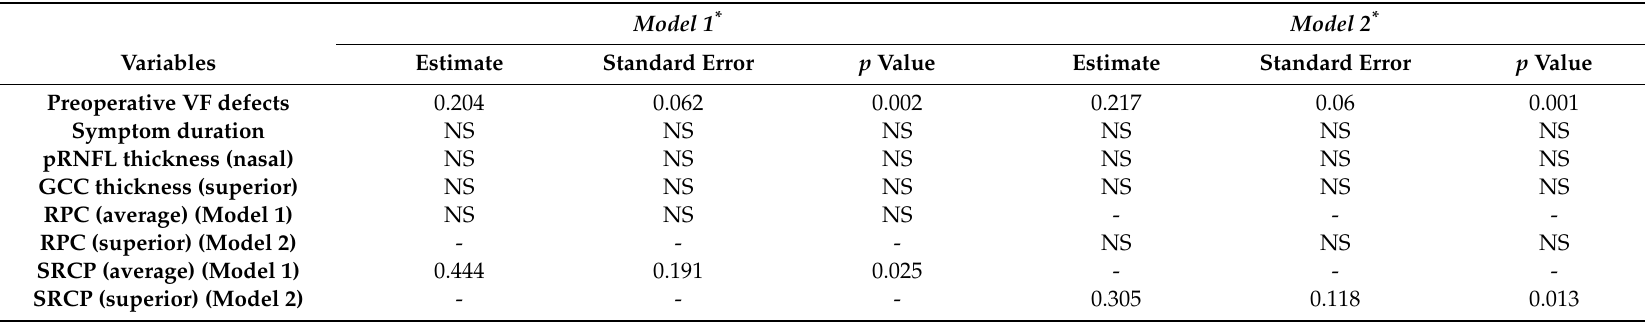
Table 4. Association between postoperative visual field defects and demographic factors and ophthalmic parameters: multivariate